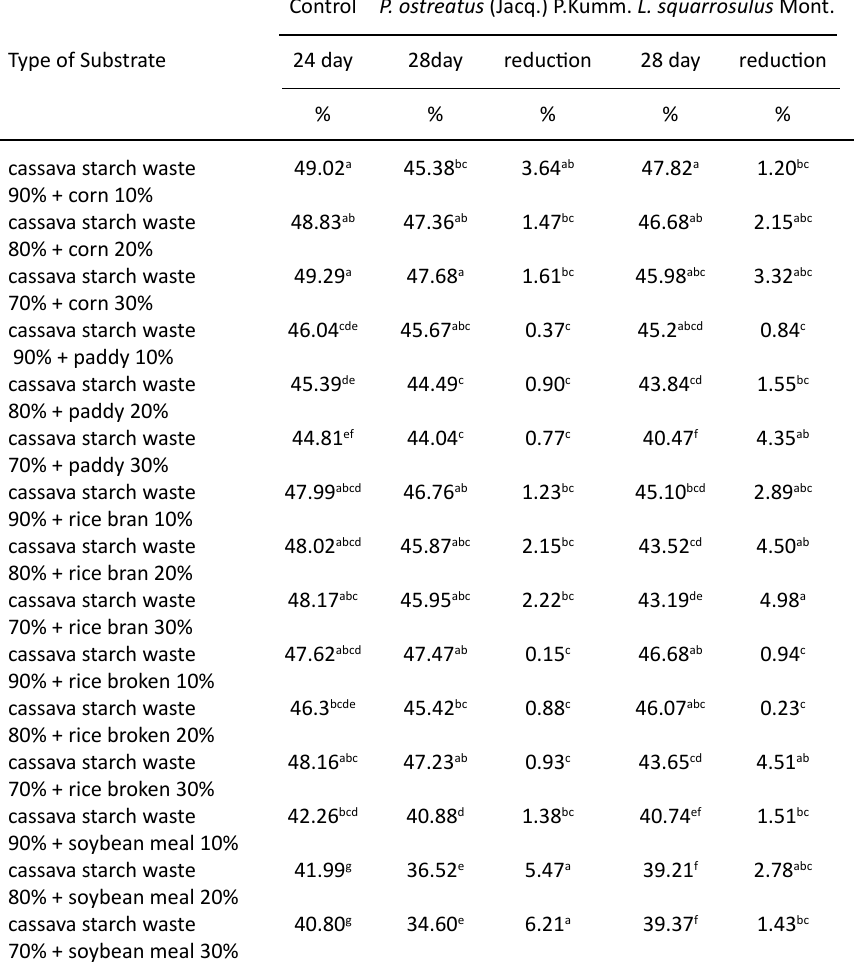
Table 4. Effect of P. ostreatus (Jacq.) P.Kumm. and L. squarrosulus Mont. on carbon percentage content at 28 day